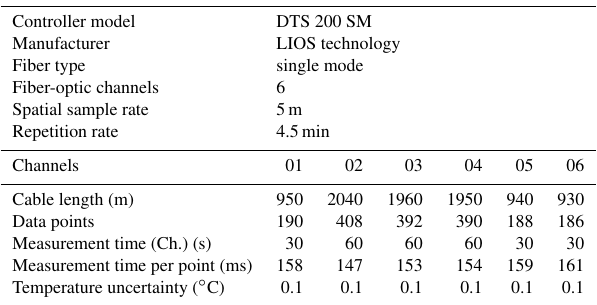
Table 1. Specifications OFDR measurements during standard mea-